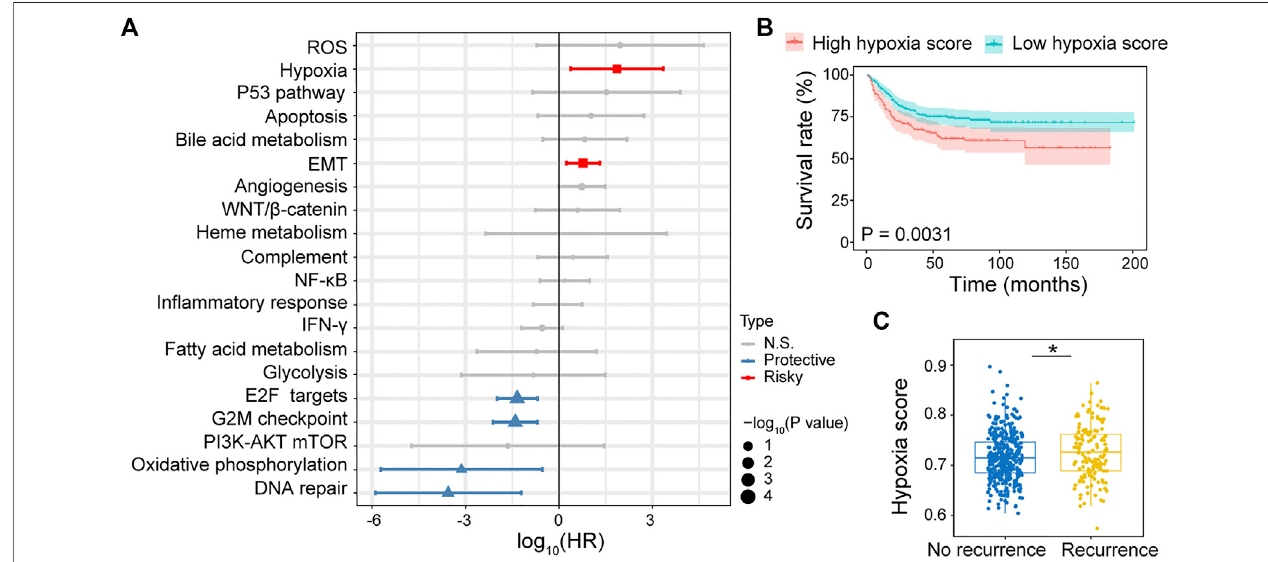
FIGURE1| Identifying hypoxia associated with CRC recurrence free survival (RFS). (A) Forest plot of hazard ratio (HR) for 20 prognostic cancer hallmarks. (B) Kaplan – Meier RFS curves for patients with high hypoxia and low hypoxia scores. (C) Comparison of hypoxia scores in recurrence and no recurrence